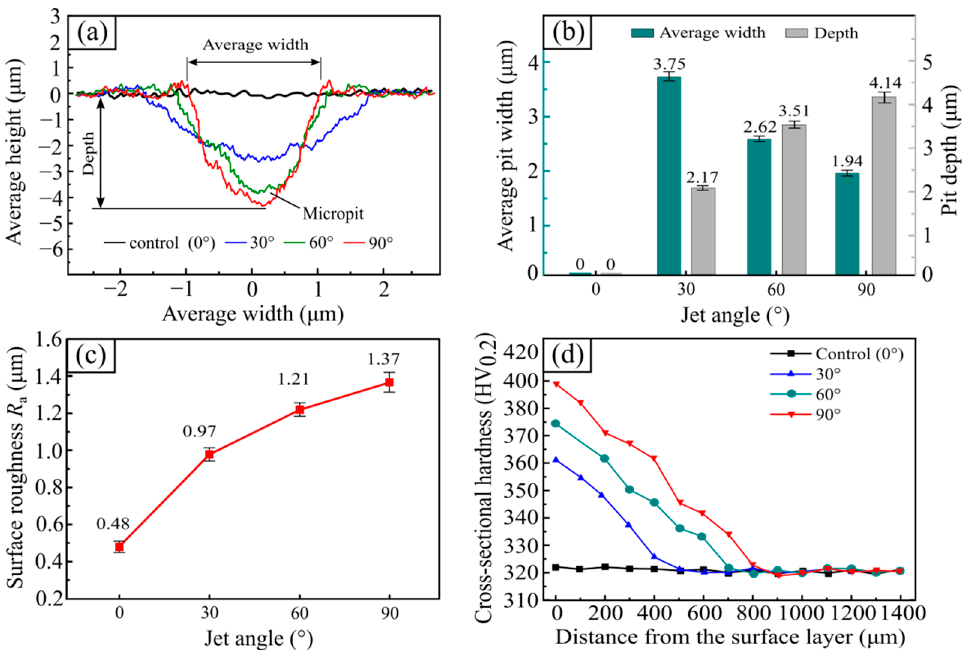
Figure 5. ( a ) Two-dimensional profile pits at different jet angles; ( b ) width and depth of pits versus jet angle; ( c ) surface roughness at different jet angles; ( d ) hardness profiles in the cross-sectional at different jet angles.